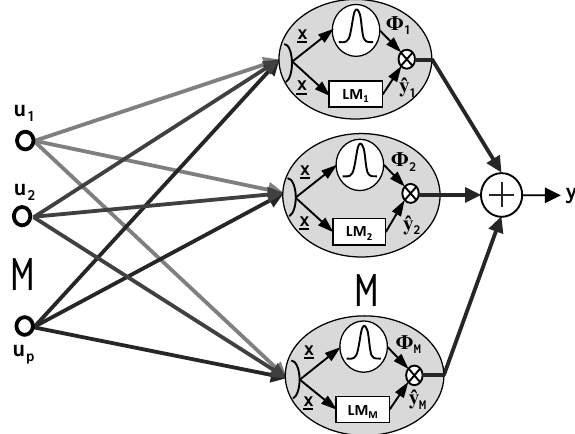
Figure 1. Structure of LMN with p inputs and M local